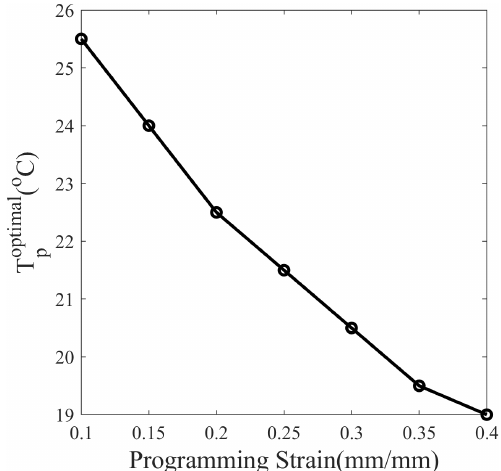
Figure 18. Dependence of optimum programming temperature ( T optimal p ) on programming strain of the